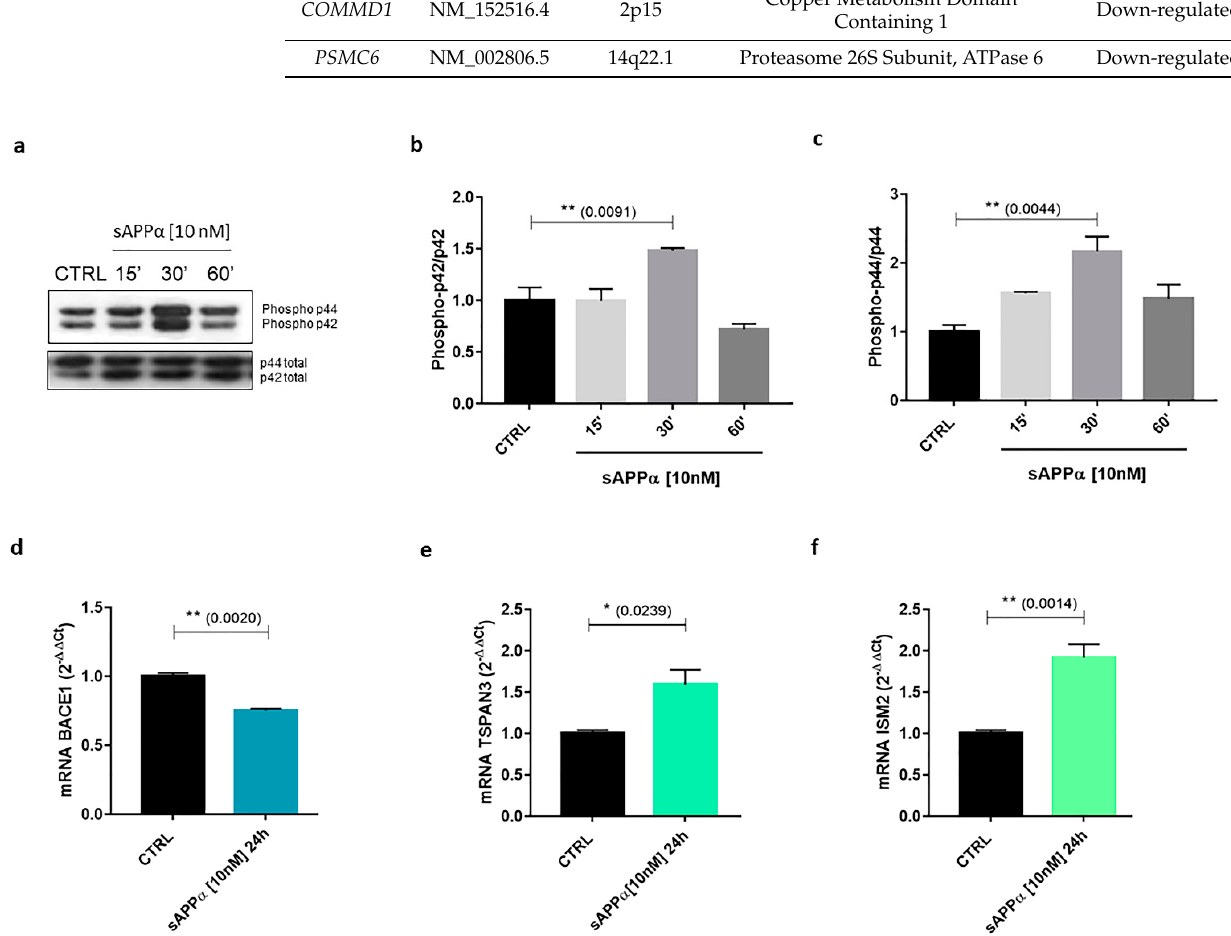
Figure 4. Effects of sAPP α treatment on early MAPK activation and BACE1 , TSPAN3 and ISM2 transcriptional regulation. Human neuroblastoma SH-SY5Y cells were cultured and treated with 10 nM sAPP α for 15, 30 or 60 min ( a – c ) or for 24 h ( d – f ) as previously detailed [141]. Western blot analysis and qPCR were performed as previously reported [141]. ( a – c ) Evaluation of early MAPK activation. The image is a representative Western blot. Phosphorylation of p42 and p44 was normalised to their respective total p42 and p44 levels. ( d – f ) Evaluation of sAPP α -mediated transcriptional regulation on BACE1 , TSPAN3 and ISM2 . mRNA levels were evaluated by qPCR (endogenous reference, RPL6 ). Results are expressed as mean ± SEM, n = 3 independent experiments. Statistical analysis was performed with one-way ANOVA followed by Dunne tt ’s multiple comparison test ( b , c ) or with Student’s t -test ( d – f ) with * p < 0.05 and ** p < 0.01 vs. control (CTRL). Statistical signi fi cance is detailed in the respective fi gure panel.